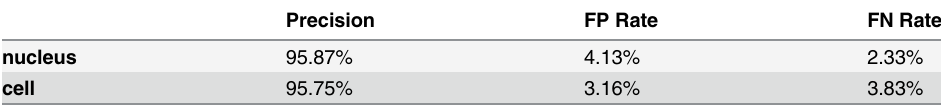
Table 4. Evaluation of the cells segmentation algorithm.